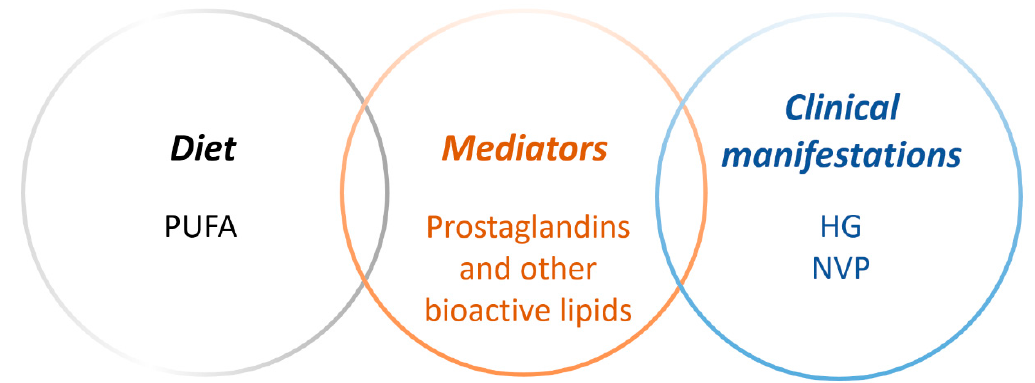
Figure 1. The aim of this review was to investigate links in the literature between dietary polyunsaturated fatty acids (PUFAs) and hyperemesis gravidarum (HG), as well as nausea and vomiting of pregnancy (NVP), with focus on bioactive lipid mediators in metabolic pathways of different PUFA precursors.